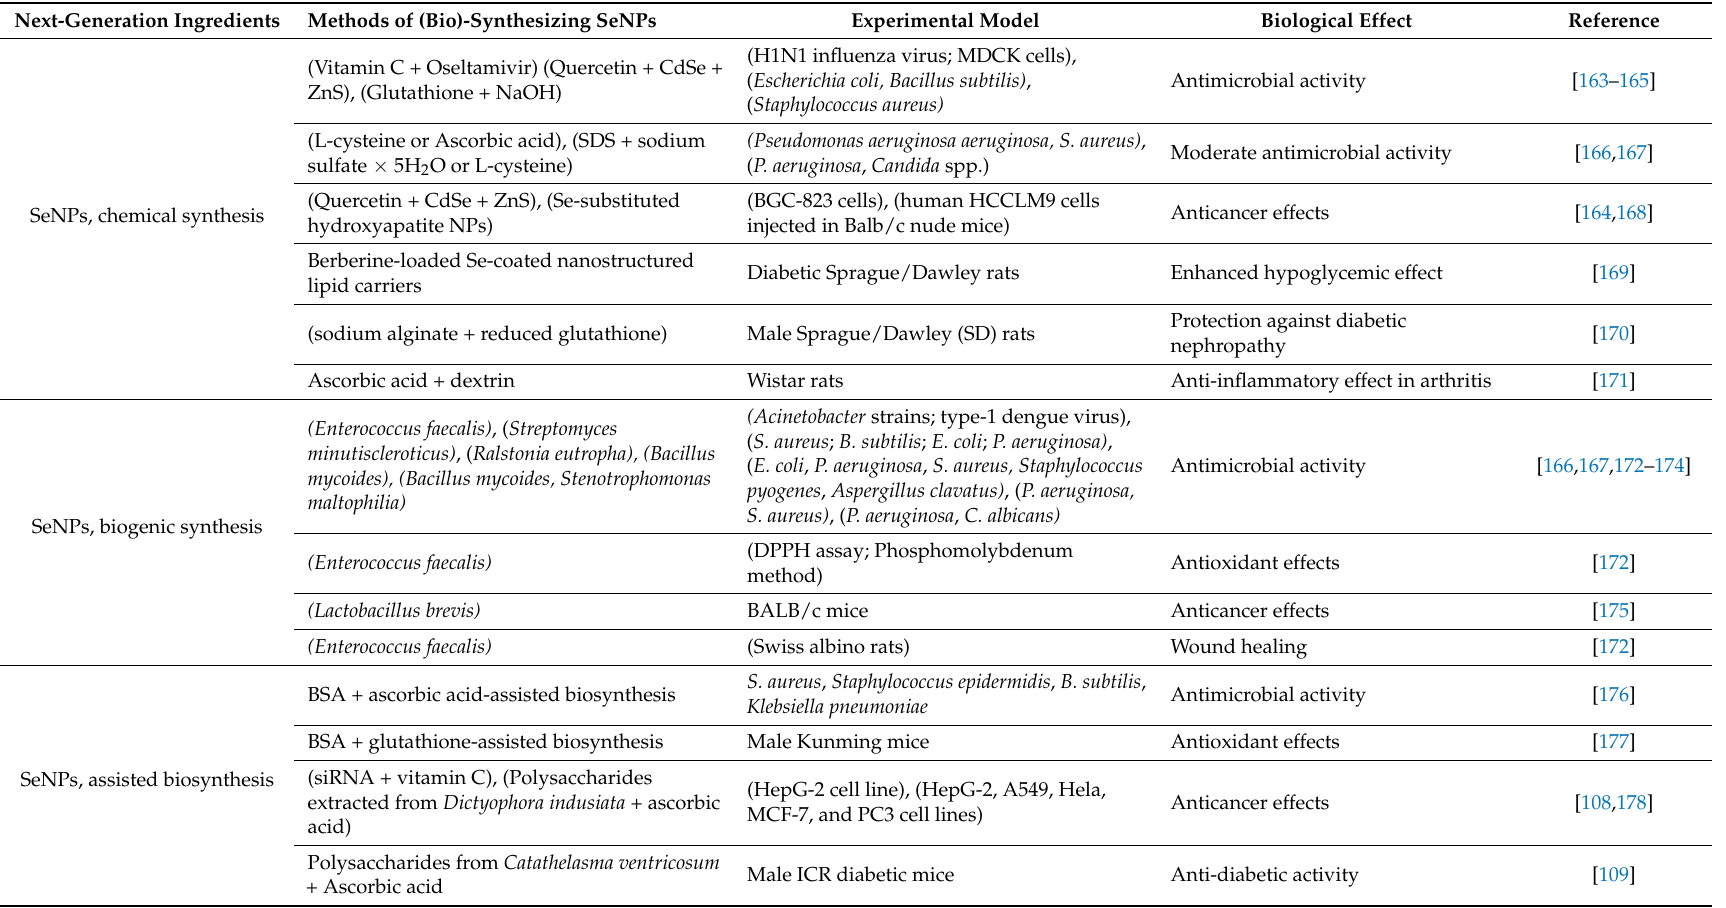
Table 1. Next-generation Se species and their biological effects